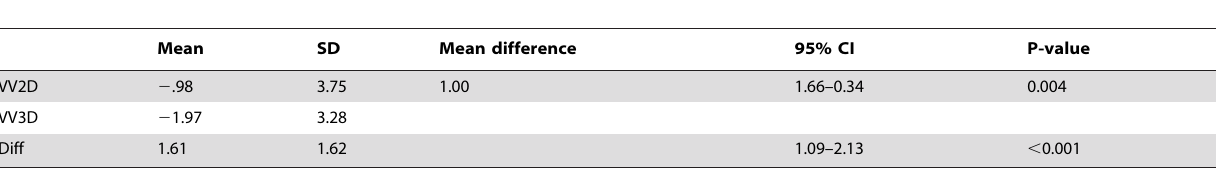
Table 2. Difference between 2D and 3D varus/valgus angle